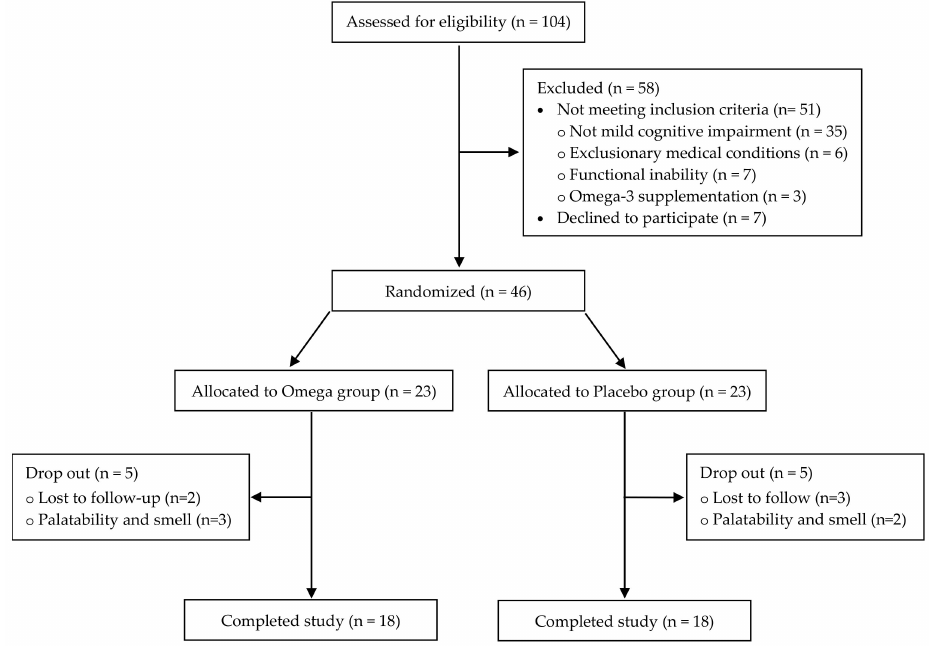
Figure 1. Flow of participants through the